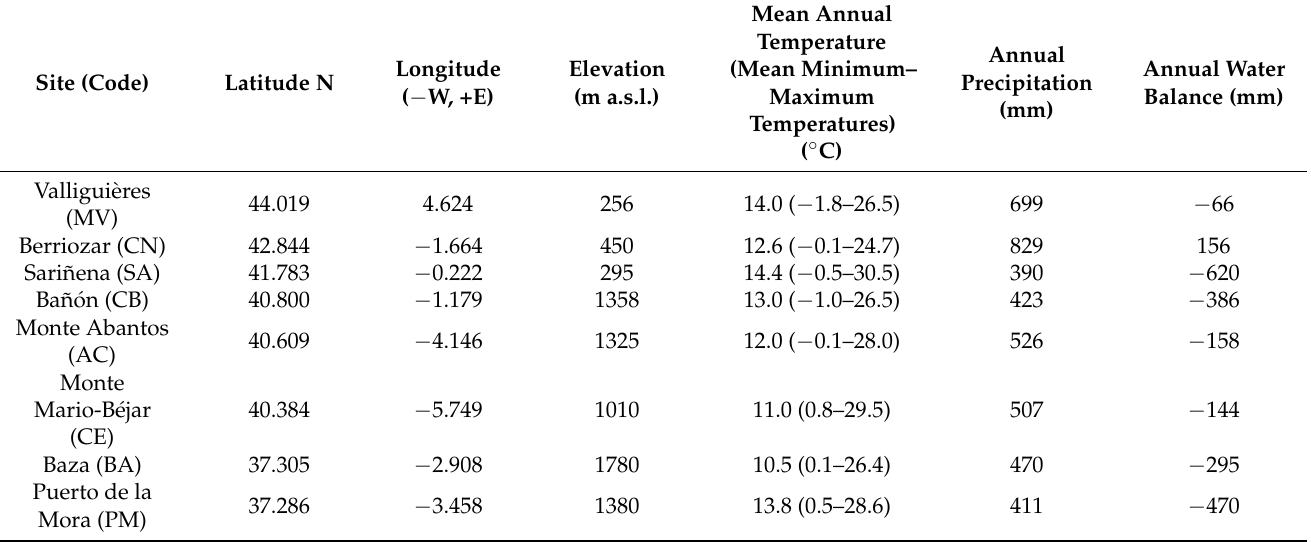
Table 1. Features of the Atlas cedar plantations studied in France and Spain. See site’s climate diagrams in Figure S1.